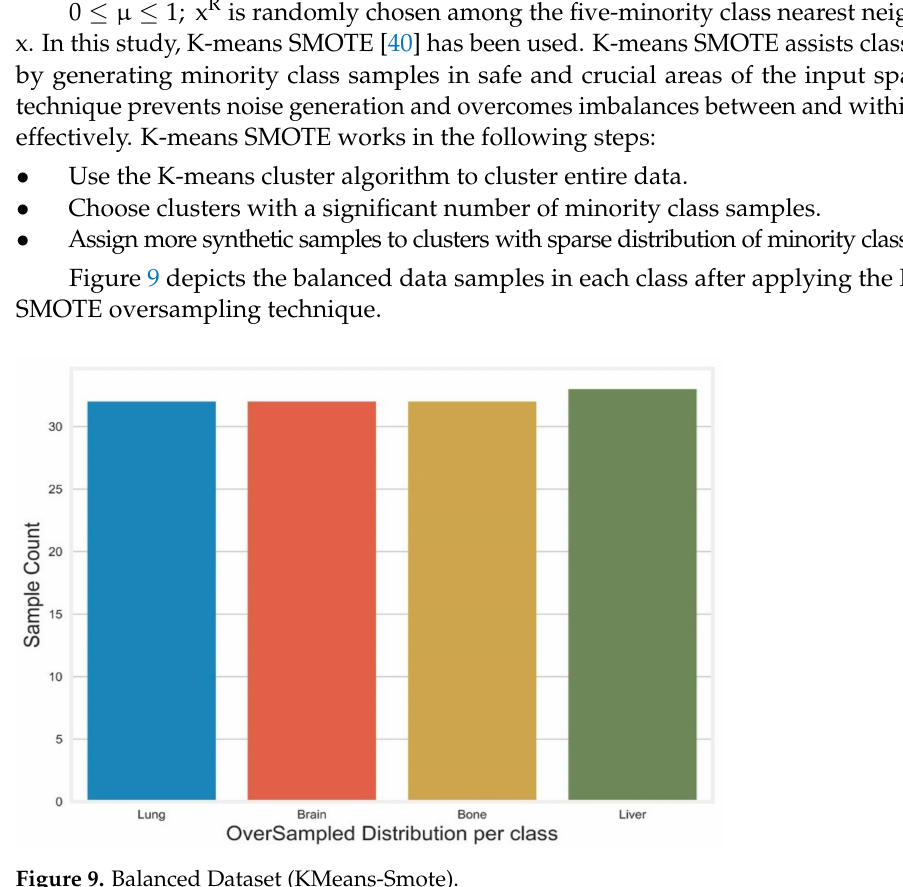
Figure 9. Balanced Dataset